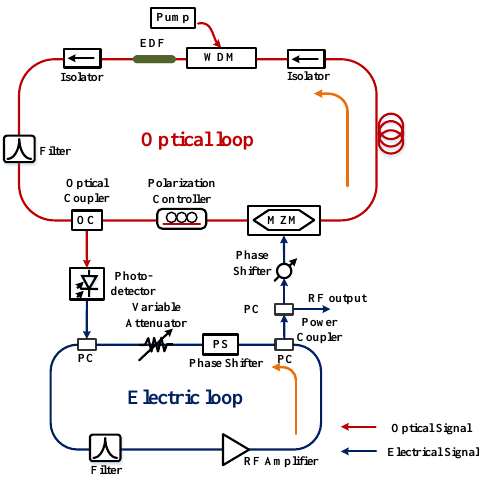
ELPF: electric low pass filter. Reprinted with permission from Ref. [38], OSA, 2018.